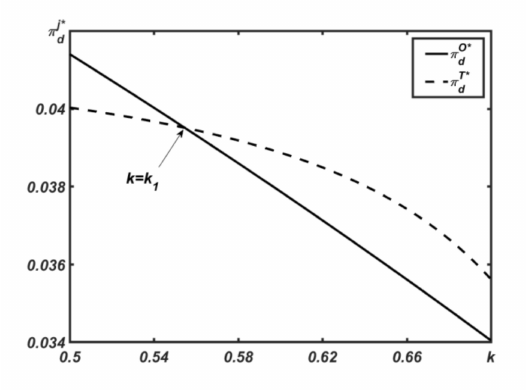
Figure 5. Variations of π j